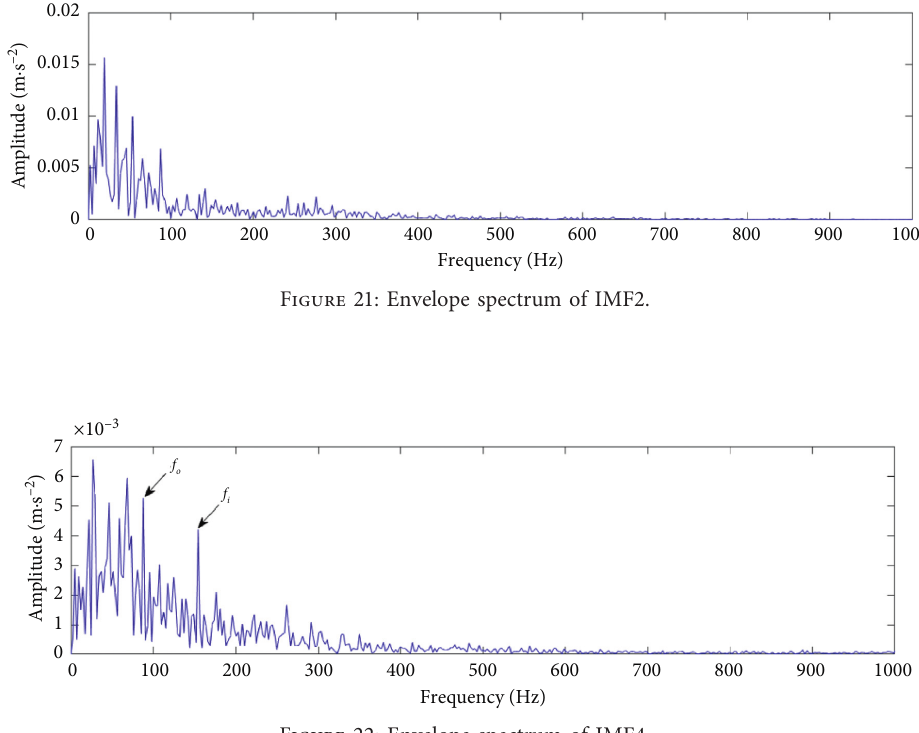
Figure 22: Envelope spectrum of